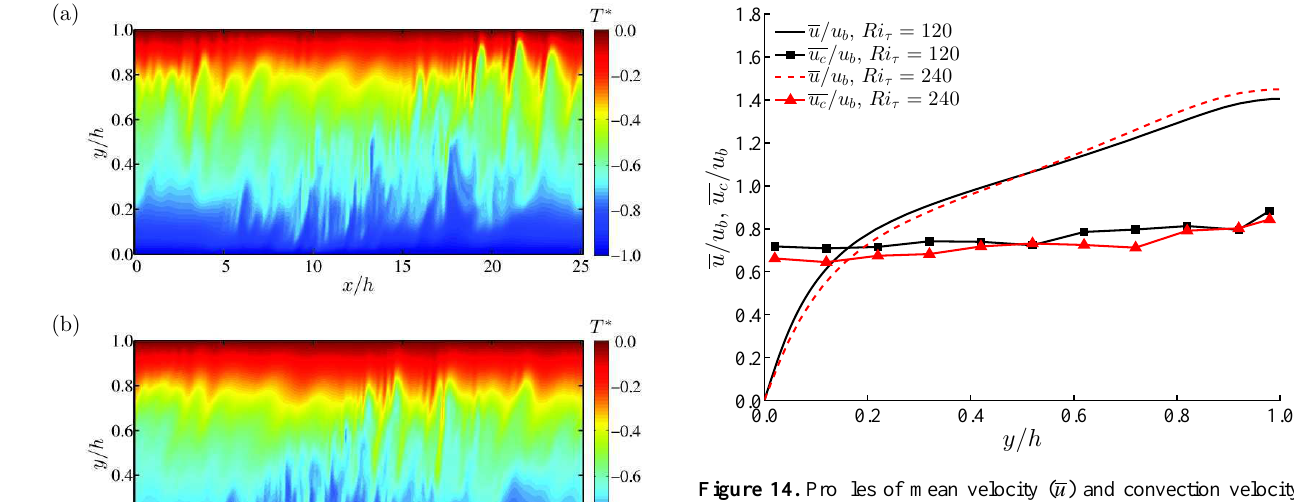
Figure 14. Profiles of mean velocity ( u ) and convection velocity ( u c ) of intermittent turbulence ( Re τ =